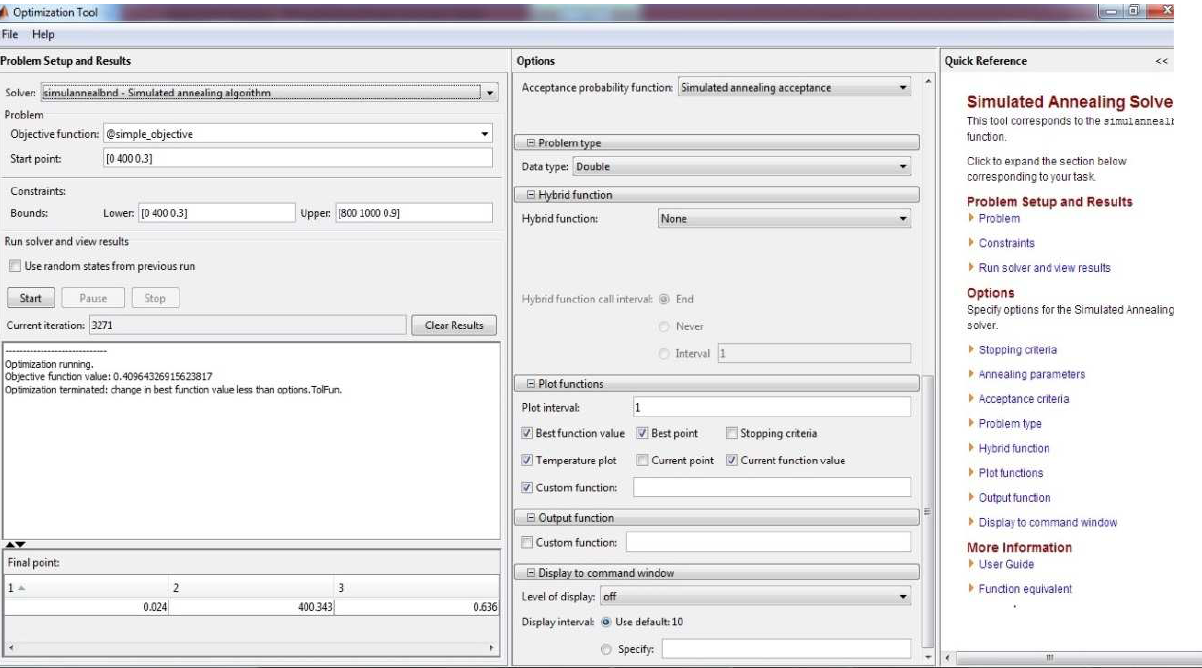
Fig. 15. Applying of Simulated Annealing Algorithm (R